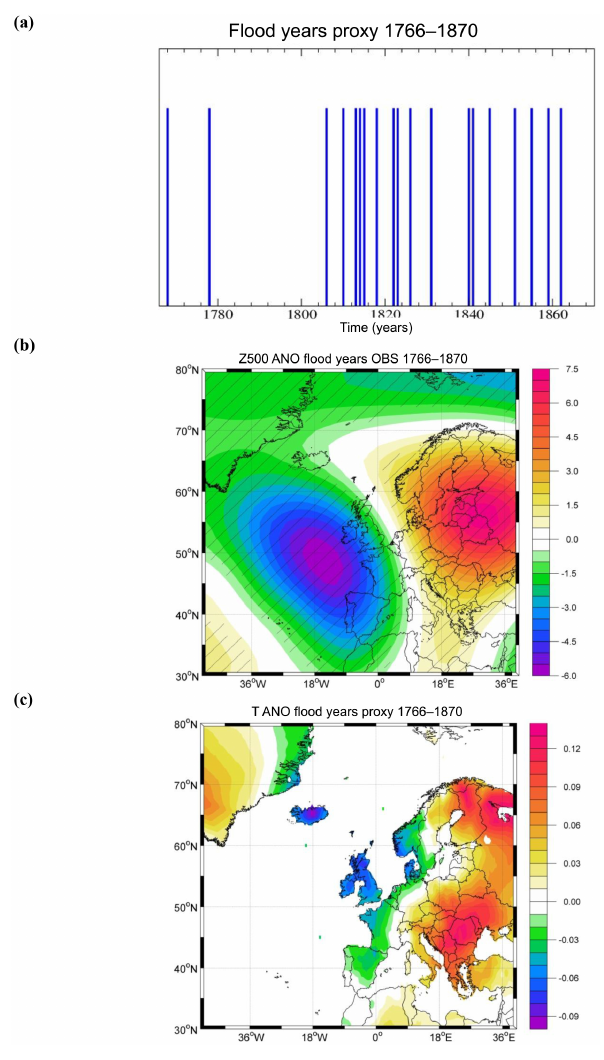
Figure 7. Same as in Fig. 6 but for the period 1766–1870.